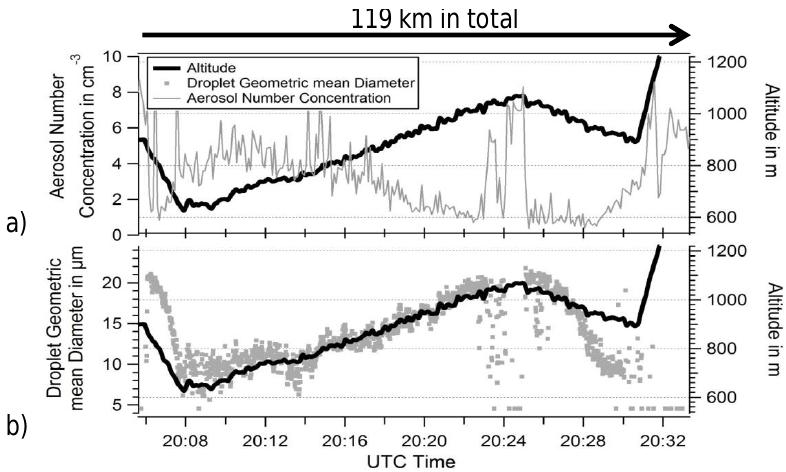
Figure 3. Time series of cloud in situ measurements: aerosol number concentration (a) (grey line) and mean cloud droplet diameter (b) (grey dots) during Flight 11 on 15 May 2012. The flight altitude is indicated in both panels by a solid black